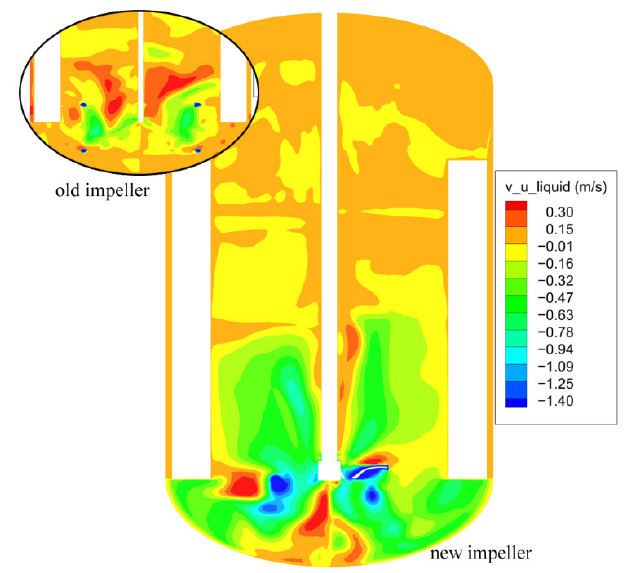
Figure 9. Tangential velocity distribution of the liquid phase, old impeller vs. new impeller.